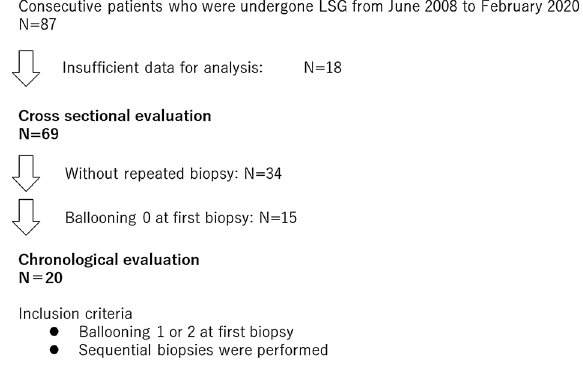
Figure 1. Patient flow diagram of the present